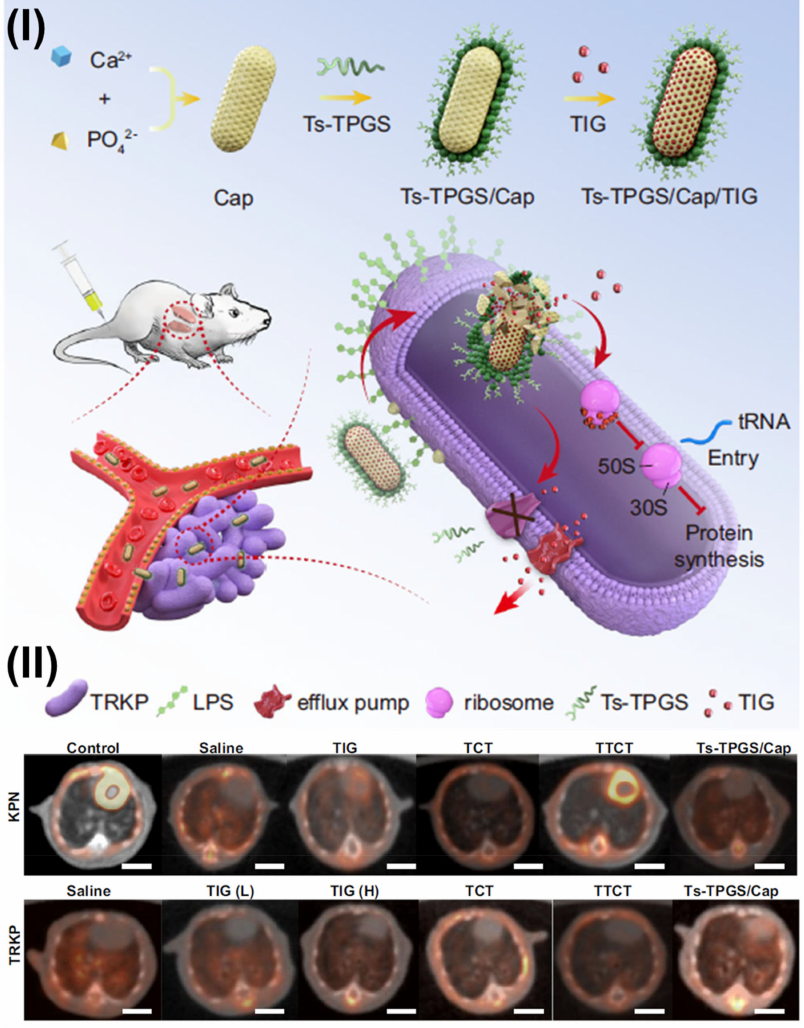
Figure 12. ( I ) Schematics show how the nanorods are put together and how the TRKP’s resistance to tigecycline can be broken; ( II ) A comparison of PET-CT scans of the lungs taken before and after dosage. Reproduced with permission from the Ref. [128], Figures 1 and 8. (Nature ©